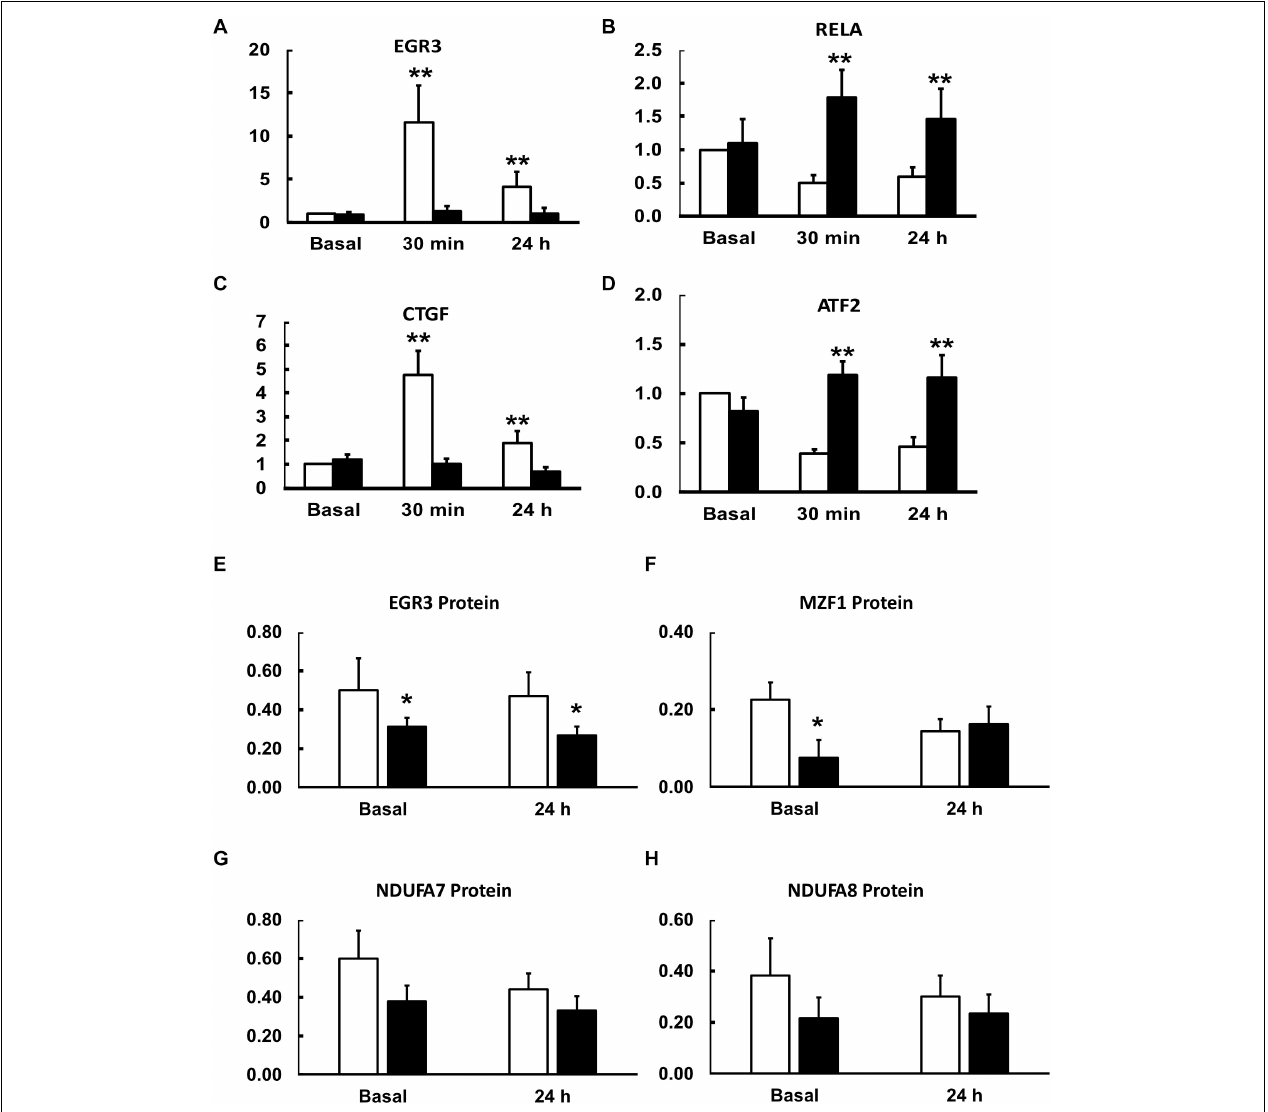
FIGURE 4 | Effects of an acute exercise bout on mRNA for transcription and growth factors (A–D) and protein abundance basally and 24 h after exercise (E–H) . Muscle biopsies were taken at rest and 30 min and 24 h after a single bout of exercise (see section “Materials and Methods”). mRNA expression levels in lean (open bars) and obese (closed bars) participants were determined by Q-rt-PCR and all values were normalized to beta-actin expression and expressed relative to resting, basal values for lean, insulin sensitive participants. Data are shown as Means ± SEM for n = 8 and 12 for lean and obese participants, respectively. ** P < 0.01 lean vs.